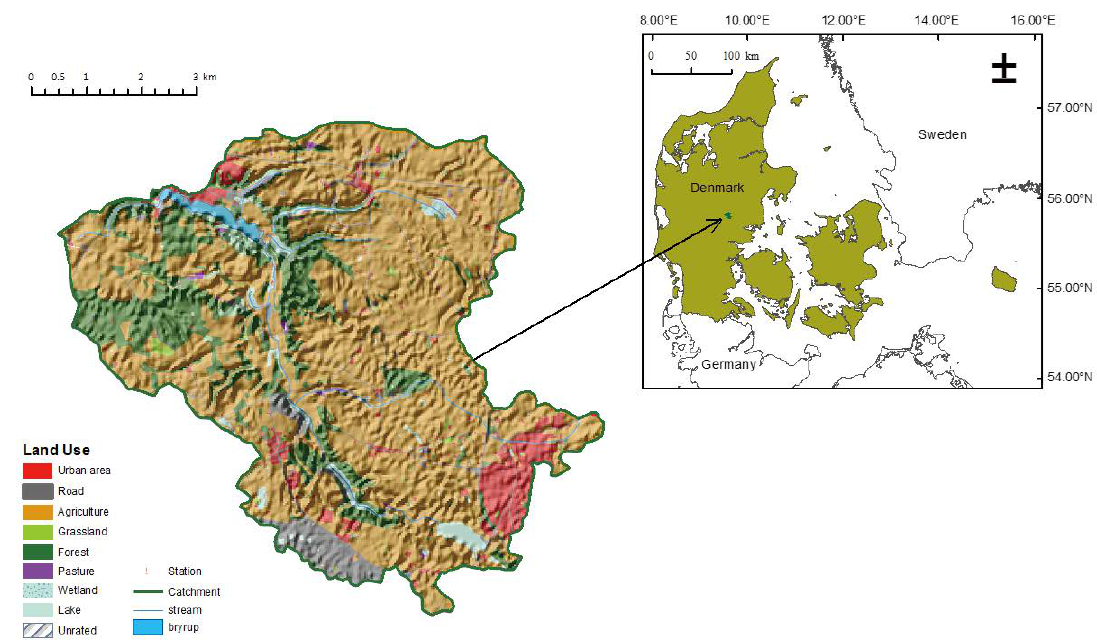
Figure 1. Map of the study lake, Lake Bryrup, and its